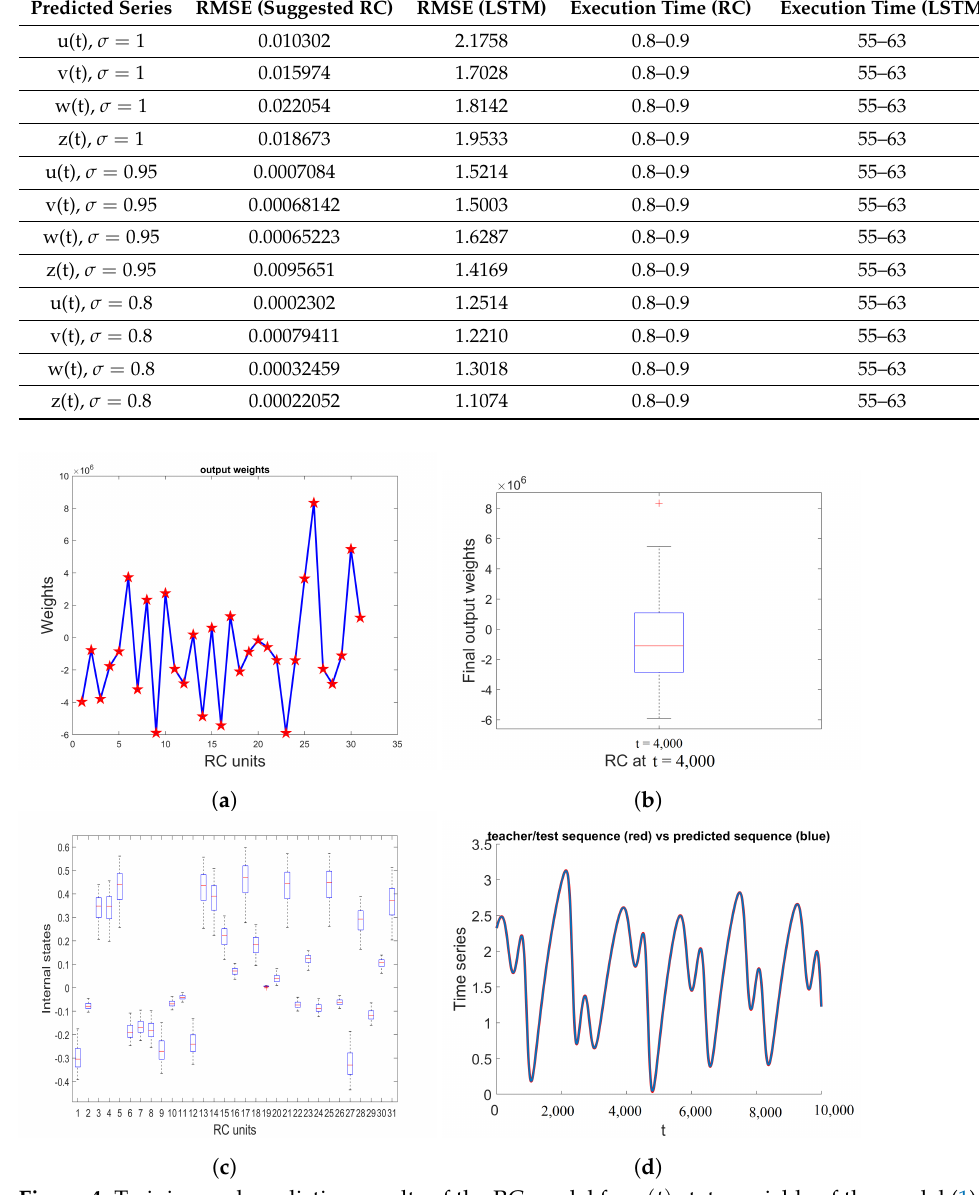
Figure 4. Training and prediction results of the RC model for v ( t ) state variable of the model (1) at σ = 1. The 70% of input data are used as the teacher sequence, whereas the last 30% of the data are set as the validation test data. ( a ) The weights of RC nodes after the completion of training. ( b , c ) The spread of the weights of RC units, illustrated using a box-and-whisker plot. ( d ) The training and test data in red color vs. predicted data in blue